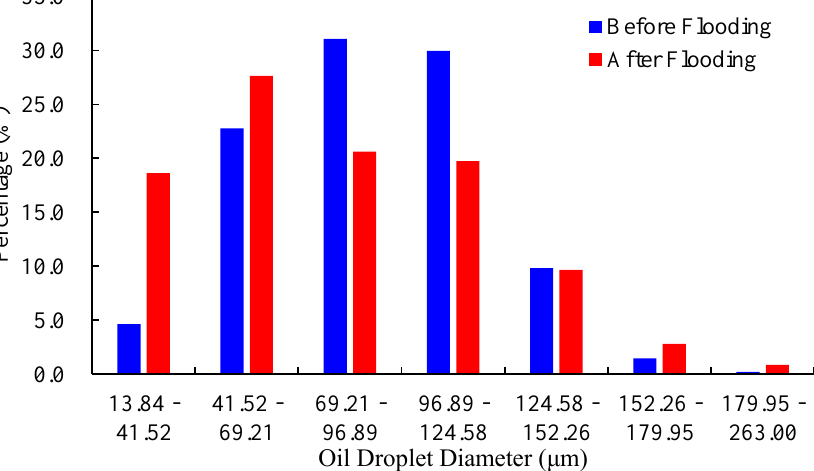
Figure 6. Frequency distribution of oil droplets during water flooding in No. 2 rock sample.